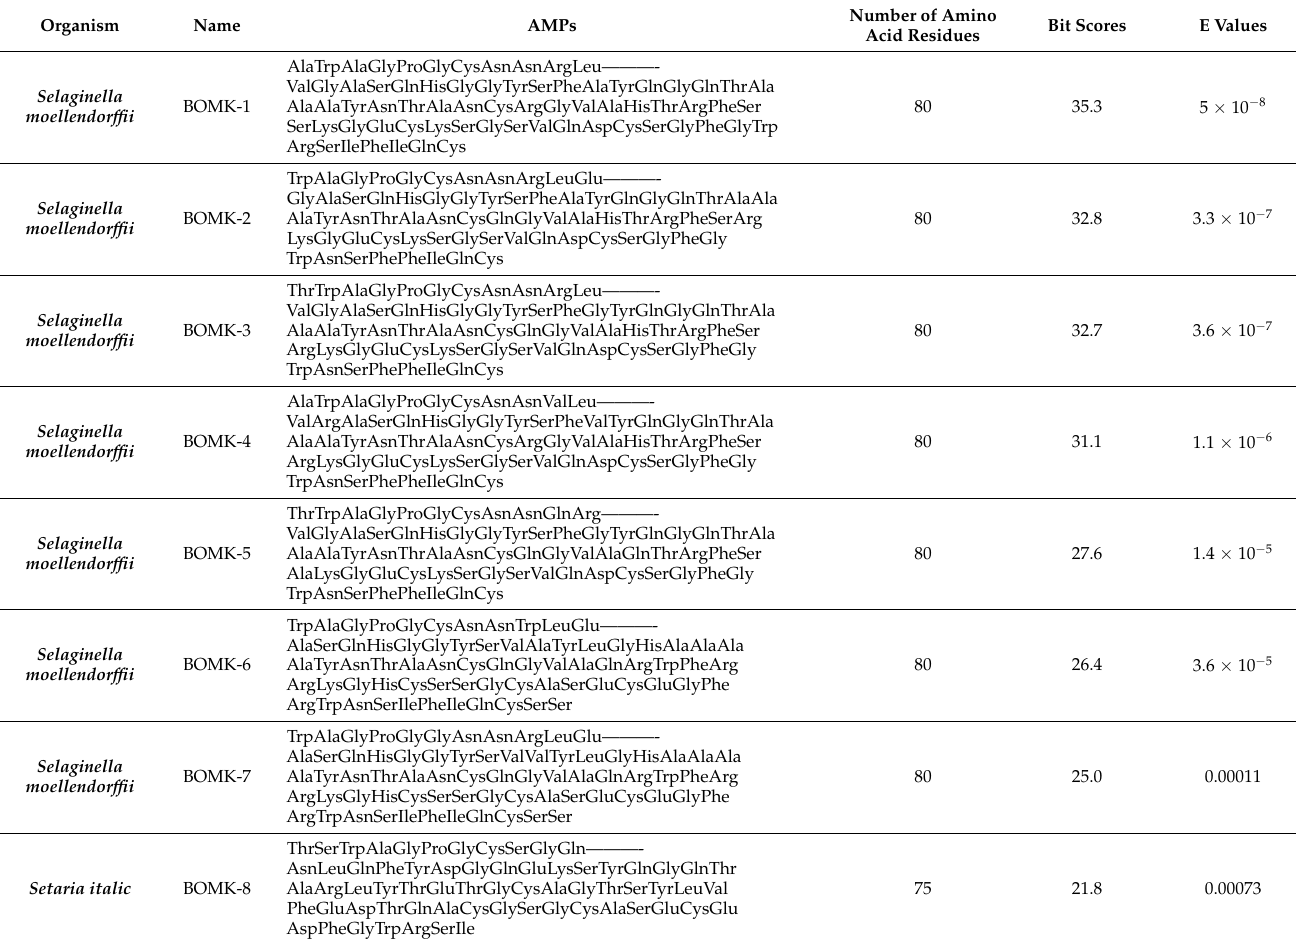
Table 3. Discovery of anti- Fusarium oxysporum